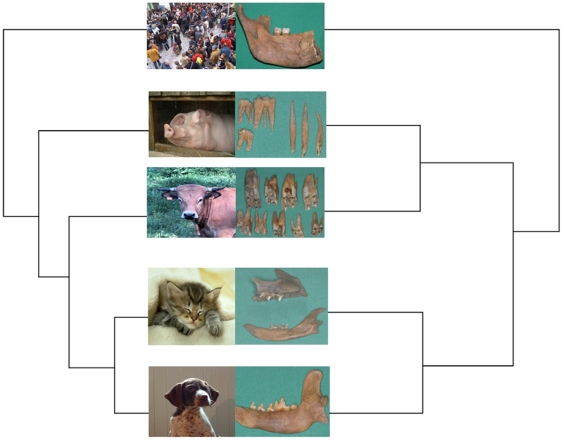
The dendrogram obtained by the software Maldi Biotyper 2.0 (Bruker Daltonics) after peptide spectral analysis is congruent with the one derived from cytochrome b sequencing by the software Tree View (Free down load from the Internet site:
http://darwin.zoology.gla.ac.uk/~rpage/treeviewx/download.html
). The images indicate the mammalian species (left) from which the ancient teeth were identified (right).